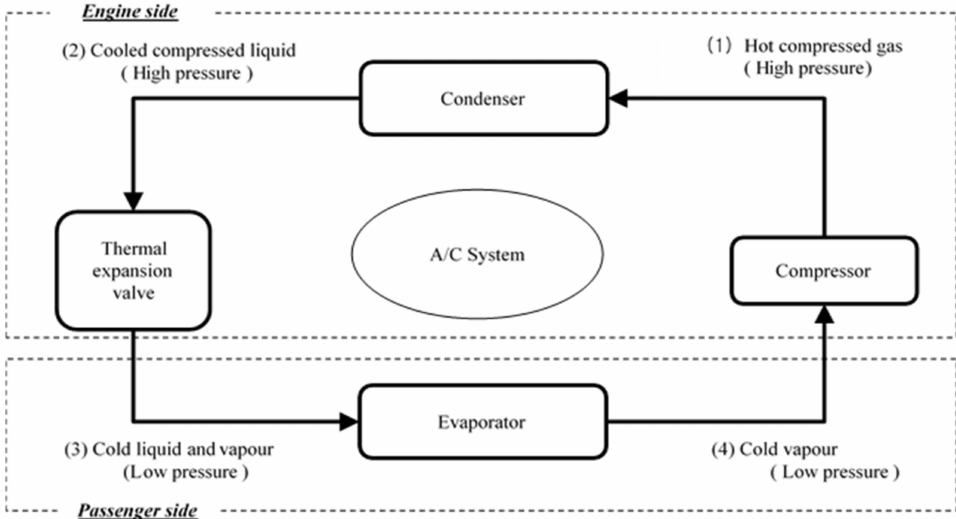
Figure 2. Circulation of refrigerant in the automotive A/C system. Source: made by authors. The A/C system consists of four major components, compressor, condenser, and thermal expansion valve (TXV) and evaporator. The A/C system uses refrigerant, such as R134a, in the circulation system. The refrigerant can absorb and release energy when it changes phases between liquid and gas. The compressor makes the refrigerant a pressur- ized gas under high pressure. Through the heat-exchange in the condenser, the refrigerant changes to a cooled compressed liquid under high pressure. A thermal expansion valve (TXV) makes the refrigerant become a cold mixture of liquid and vapor under low pressure. The evaporator is located on the passenger side and is a heat-exchanging component which absorbs surrounding heat to cool the atmosphere. The cooled air is forced into the passenger side by an electric motor. An automotive A/C system is typically B2B product of which buyers request perfect quality, good function and competitive price for a large purchasing